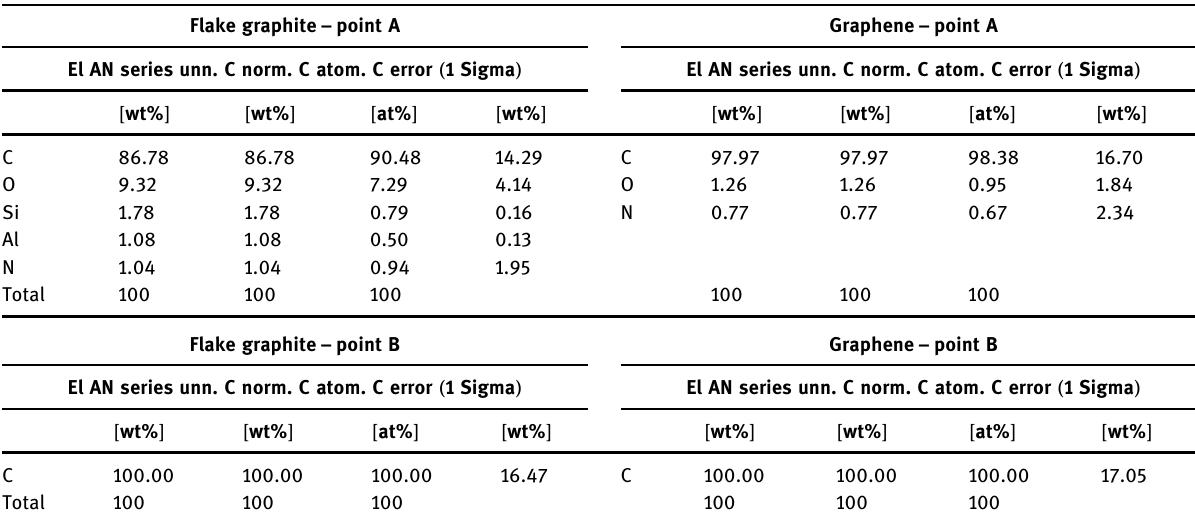
Table 2: EDX elemental composition for fl ake graphite and graphene Flake graphite – point